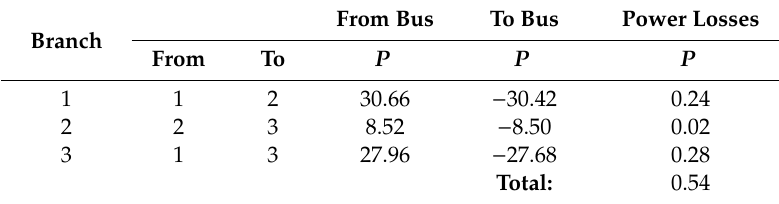
Table A7. Results of the mixed AC / DC PF calculations in Case 2. DC branch data.